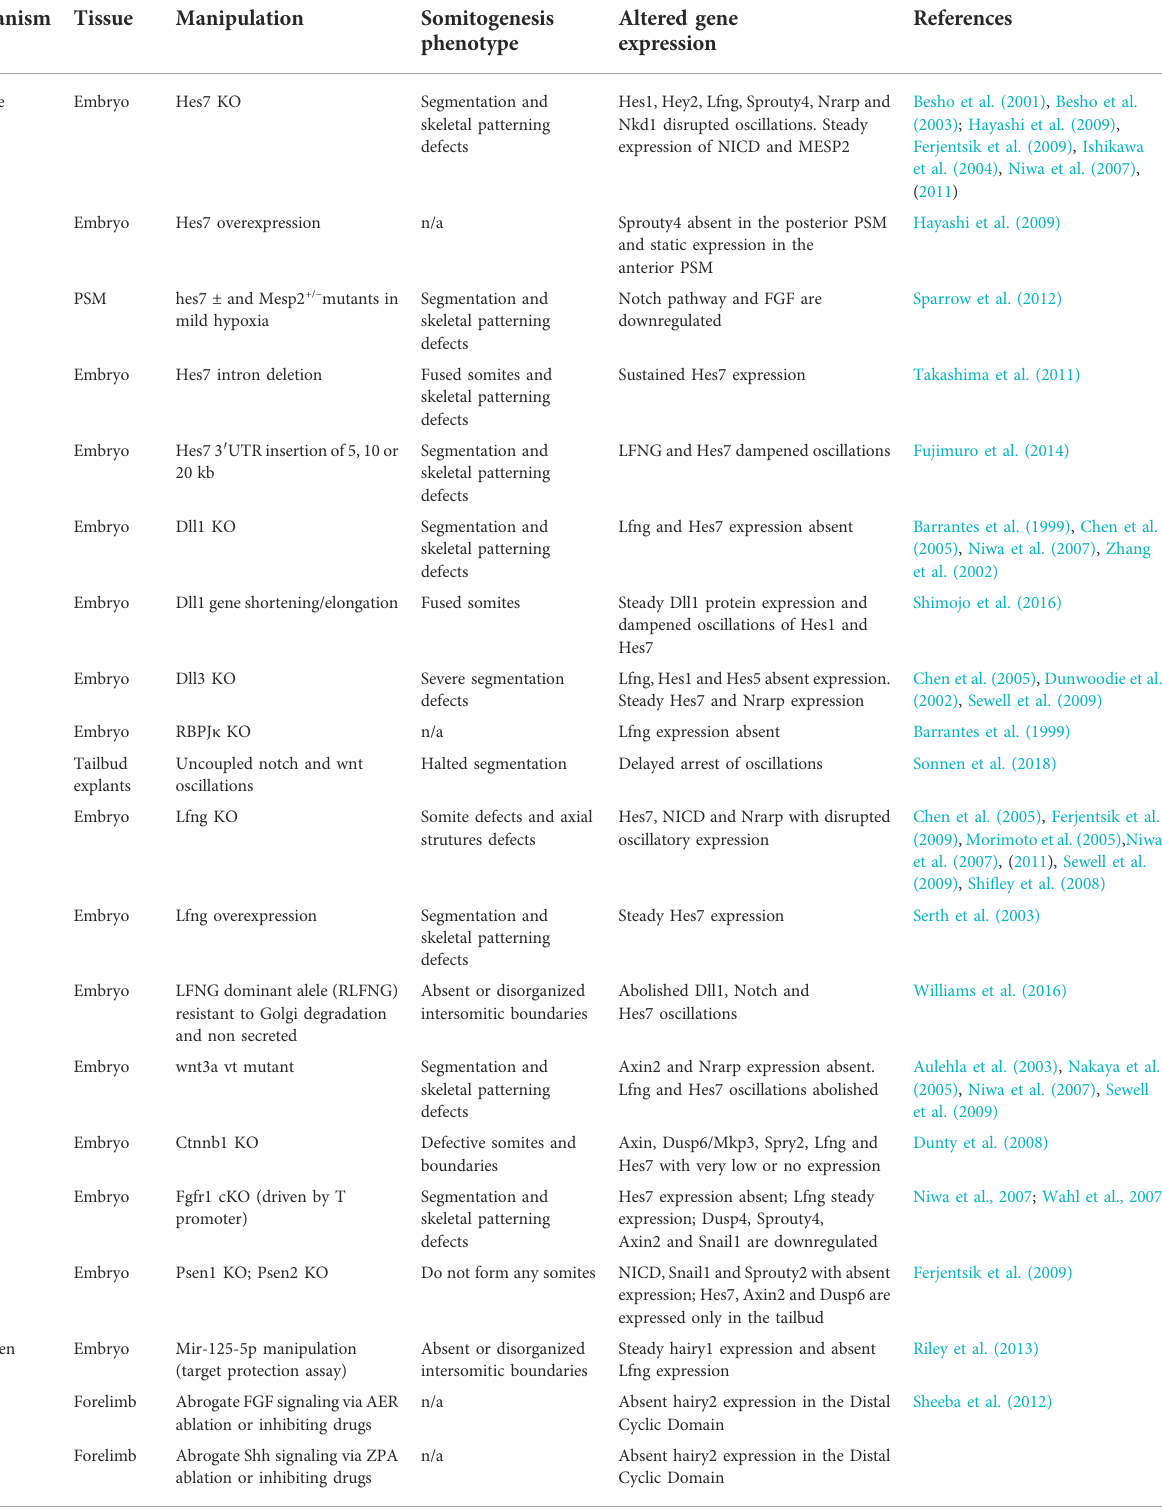
TABLE 4 Experimental disruption of Embryo Clock